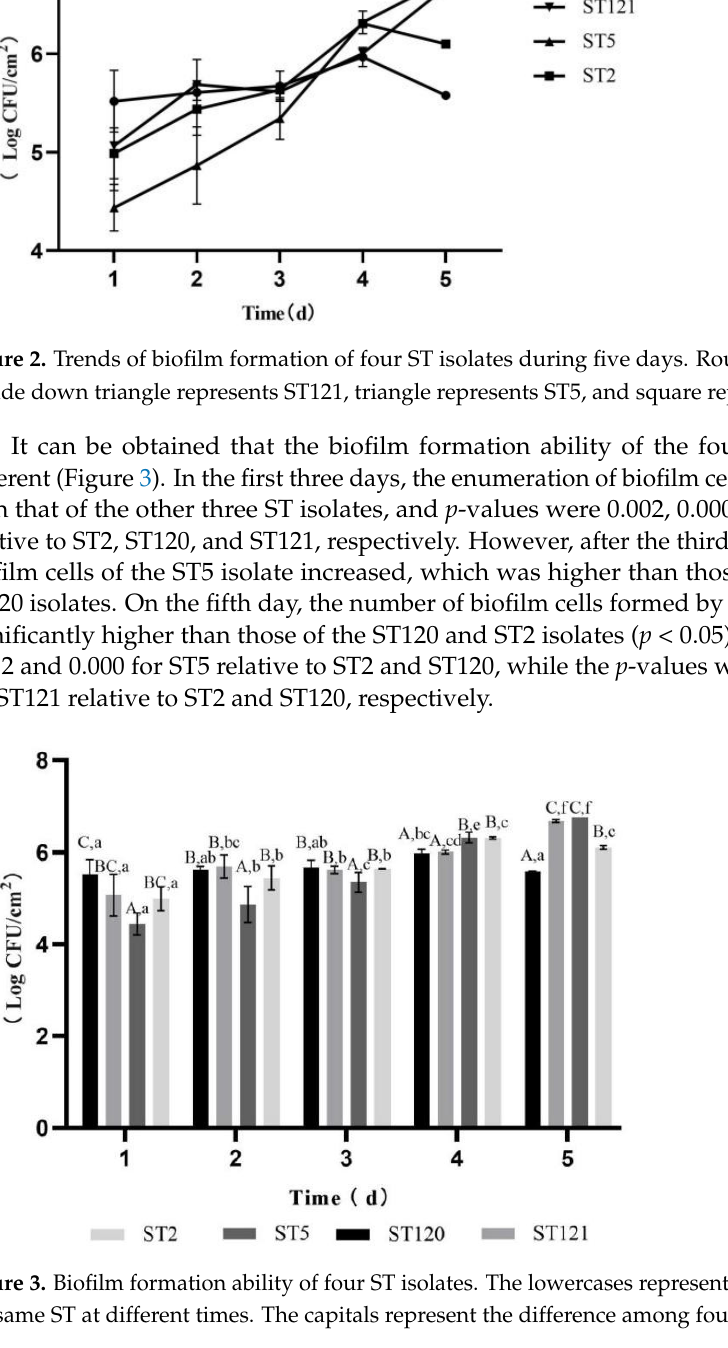
Figure 3. Biofilm formation ability of four ST isolates. The lowercases represent the difference among the same ST at different times. The capitals represent the difference among four ST at the same